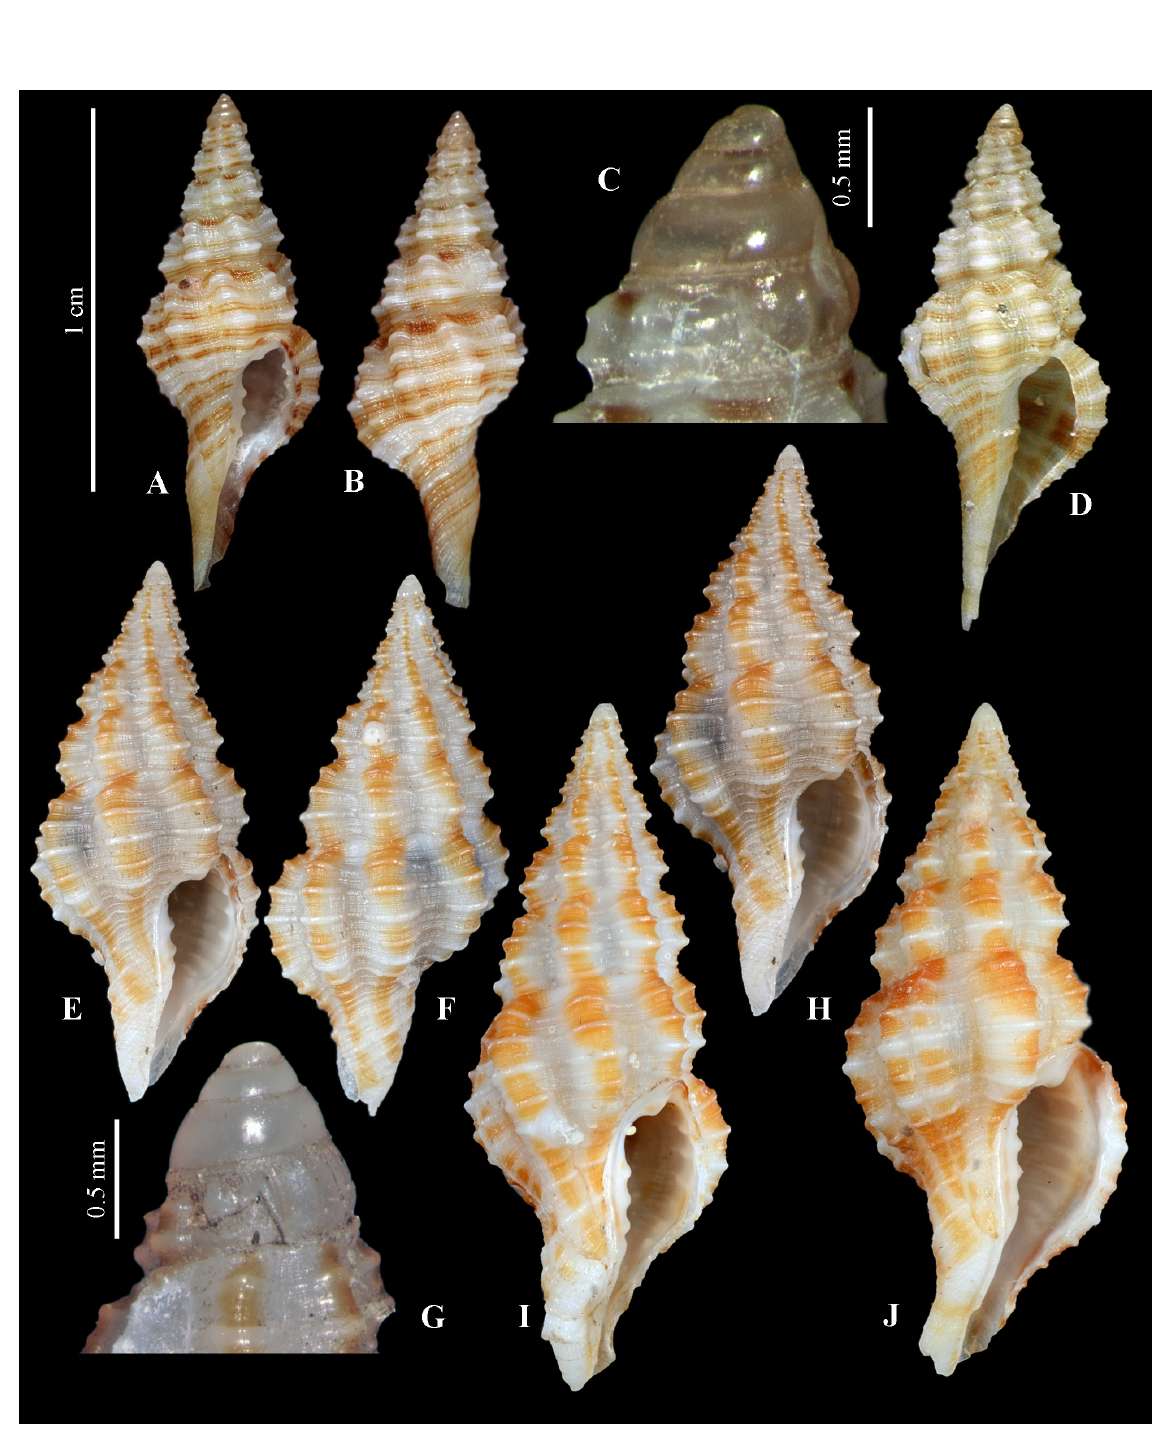
Fig. 7. A–D . Granulifusus norfolkensis sp. nov. A–C . Holotype, SL 13.0 mm, sequenced (MNHN IM-2013-68811). D . New Caledonia, Norfolk Ridge, 23°23′ S, 168°00′ E, 430–480 m, sequenced specimen (MNHN IM-2007-36921). E–J . Granulifusus tatianae sp. nov. E–G . Holotype (MNHN IM- 2000-33595). H . Paratype, SL 15.0 mm (MNHN IM-2000-33596). I . New Caledonia, SMIB 3, stn DW8, 24°45′ S, 168°08′ E, 233 m , SL 18.1mm. J . New Caledonia, CHALCAL 2, stn DW84, 23°24′ S, 168°07′ E, 170 m, SL 17.7 mm. All shells to the